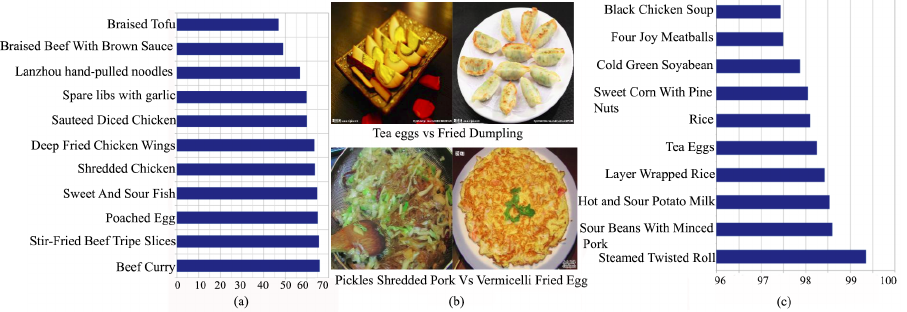
Figure 20. VireoFood-172 classification results ( a ) Worst performing classes ( b ) Confused classes ( c ) Best performing classes.